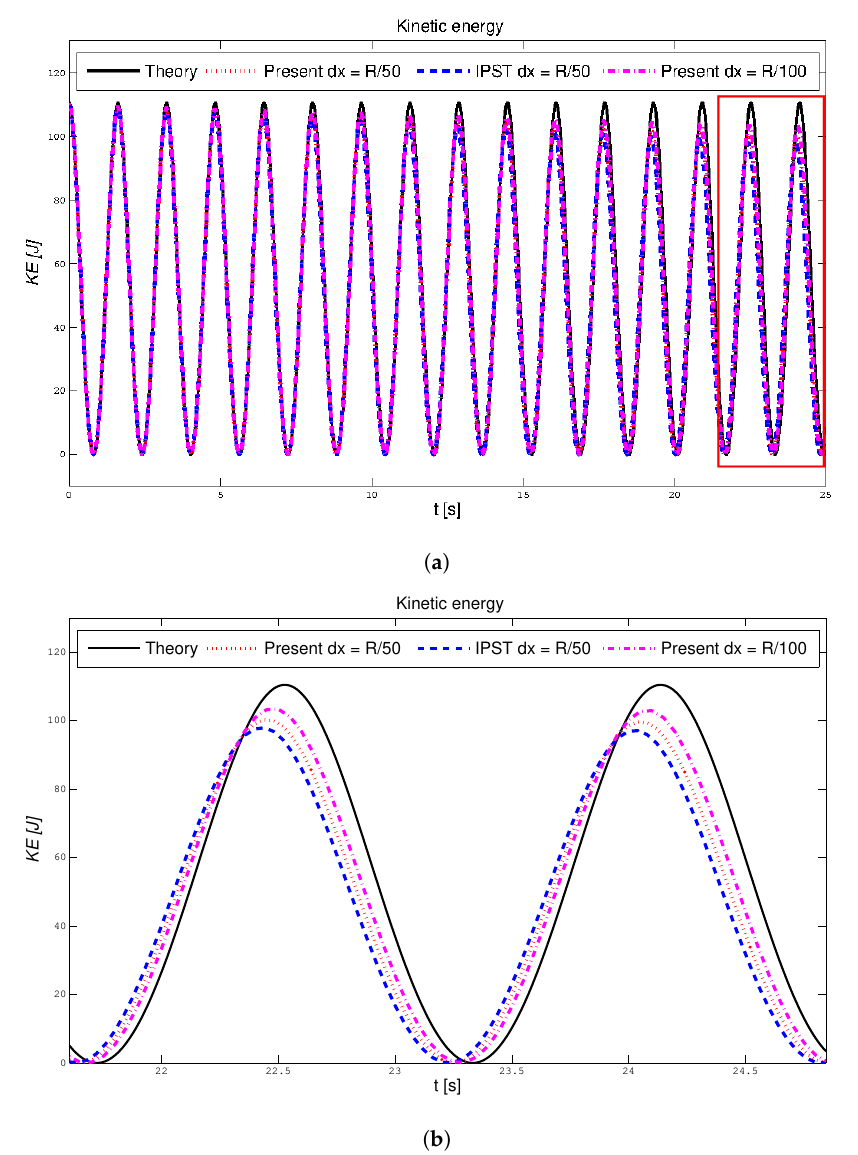
Figure 10. Oscillating droplet under a central conservative force field: Kinetic energy evolution in time E k ( t ) . The black solid line presents the theoretical results obtained by solving the system (18) [60]. The red dotted line represents the results obtained by the present particle shifting formulation for the fluid droplet of resolution dx = R , whereas for the magenta dash-dot line is for dx = R . The blue 50 100 dashed line represents the results obtained by the particle shifting technology (IPST) proposed by Wang et al. [37]. The bottom part ( b ) of the figure represents the zoom of selected red rectangle in ( a